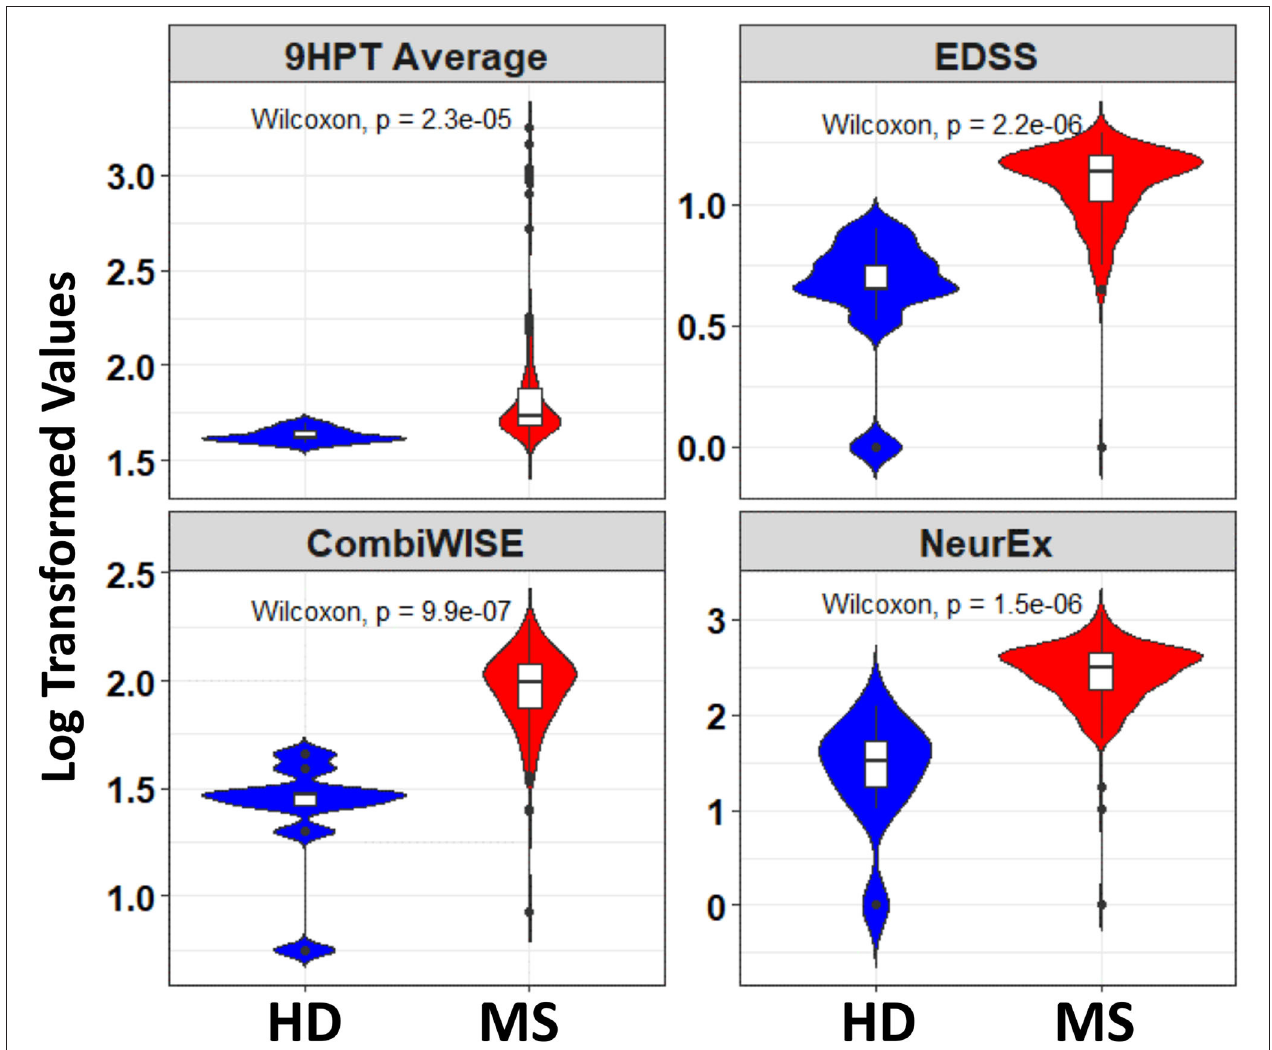
FIGURE 4 | Violin and boxplot of selected clinical disability scales with respect to healthy donors and patients with MS. The blue color indicates the healthy donors while red shows patients with MS. There were multiple tests per subject in the MS group. Values are shown using a bi-symmetric log transformation (The p indicates the p -value of the unpaired Two-Samples Wilcoxon test for the mean comparison of HD and MS groups).